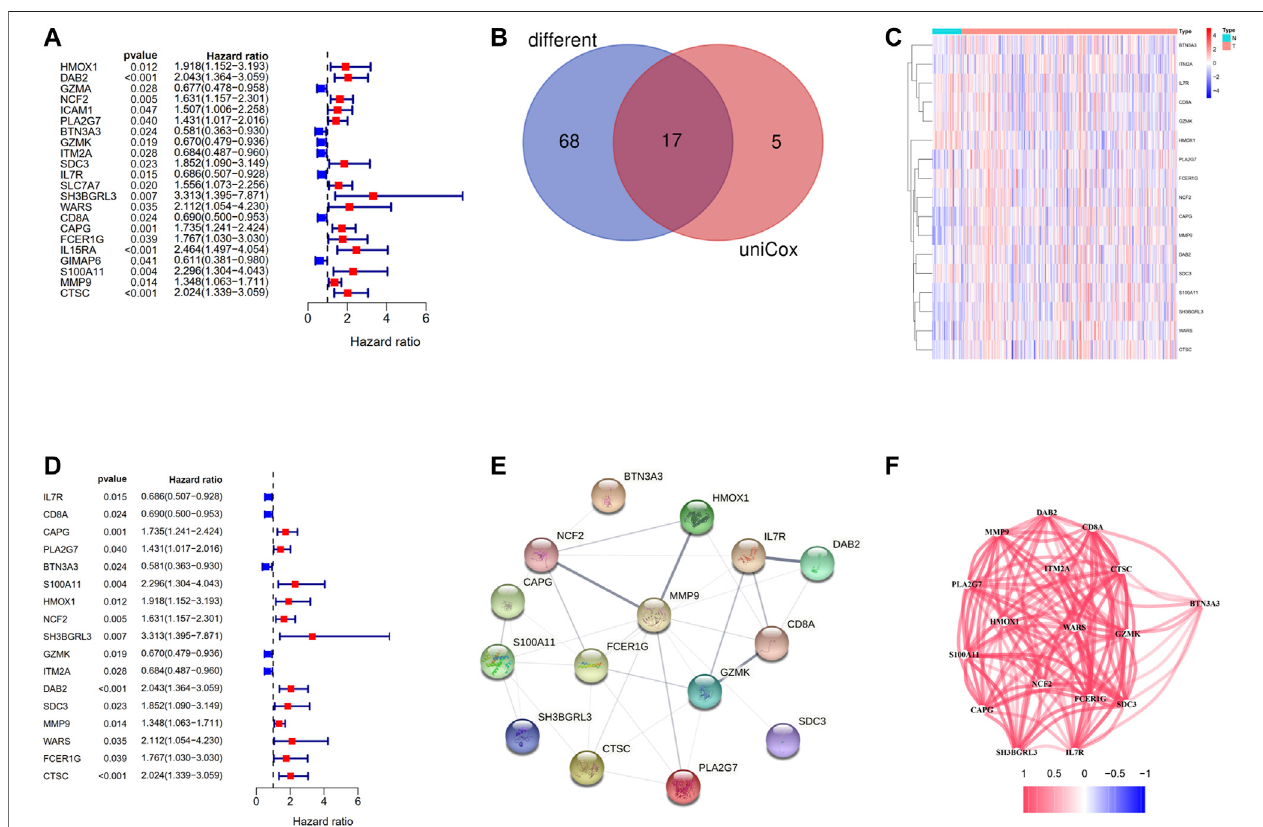
FIGURE5| Identi fi cationofthecandidateDC-relatedgenesintheTCGAcohort. (A) TheresultsoftheunivariateCoxregressionanalysisof146overlappinggenes. (B) Venn diagram to identify differentially expressed genes between tumor and adjacent normal tissue that were correlated with OS. (C) The heat map of 17 prognostic DC-related DEGs. (D) The results of the univariate Cox regression analysis between gene expression and OS. (E) The PPI network of 17 prognostic DC-related DEGs downloaded from the STRING database. (F) The correlation network of 17 prognostic DC-related DEGs.